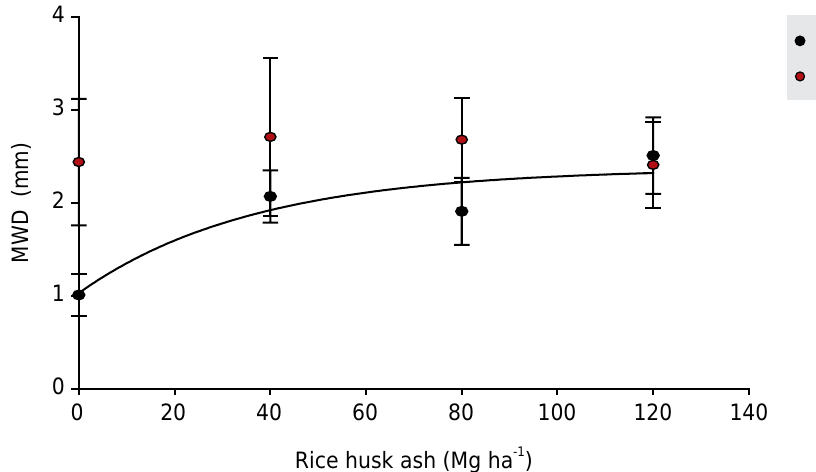
Figure 3. Mean weight diameter (MWD) of a Typic Hapludult under different rates of rice husk ash in the 0.00-0.10 and 0.10-0.20 m layers.